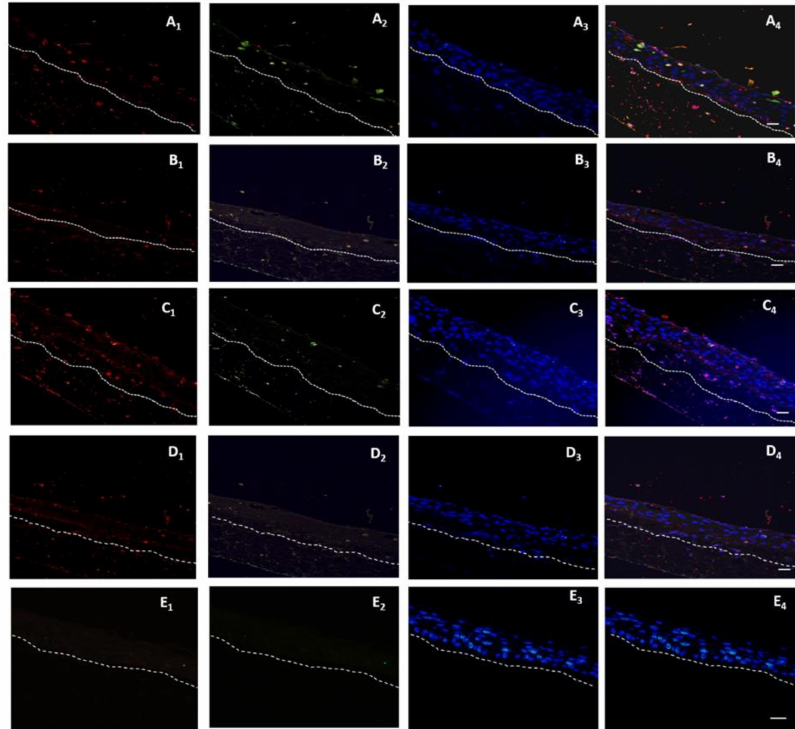
Figure 3. A double-labeling assay for detection of the staphylococcal invasion of the skin model with anti- Staphylococcus aureus antibody and detection of the apoptotic cells, using TUNEL assay after 48 h of infection the MRSA. ( A ) ST30 and ( B ) ST30 ∆ vraR , ( C ) USA300 and ( D ) USA300 ∆ vraR , ( E ) PBS. ( 1 ) the anti- Staphylococcus aureus antibody with goat anti-rabbit IgG H and L conjugated with Alexa Fluor 568 secondary antibody, ( 2 ) the Click-iT ® TUNEL Alexa Fluor ® 488 cells ( 3 ) Hoecsht stain, and ( 4 ) the overlay of the emission signals. White hashed line demarcates the dermal epidermal boundary between the strata basale and the collagen gel populated with fibroblasts. Scale bar shows 50 µ